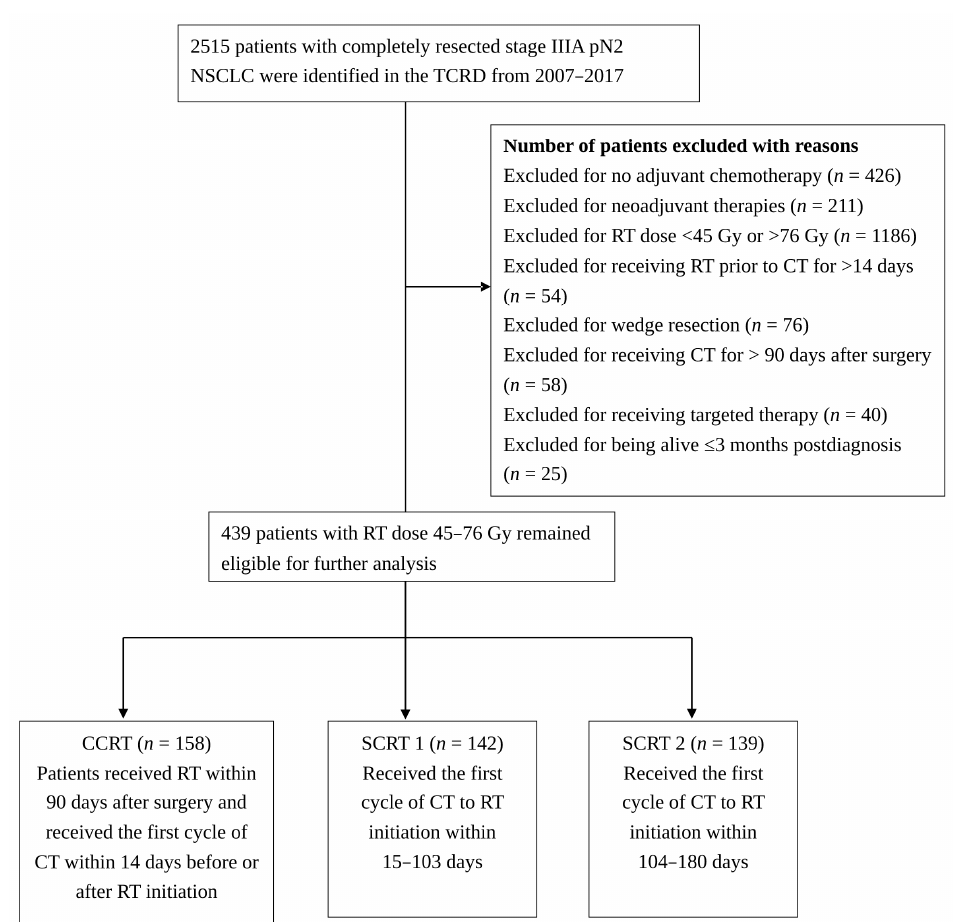
Figure 1. Flow chart representing the selection of completely resected pN2 NSCLC patients over